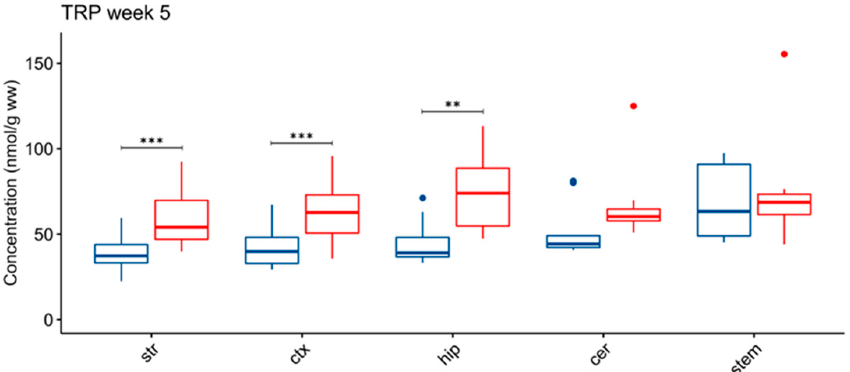
Figure 6. Elevated tryptophan concentrations in some brain regions in the cuprizone-treated group. In the 3rd week of CPZ treatment, the TRP levels were significantly increased in the cortex and the hippocampus. By the 5th week, the TRP concentration was also significantly increased in the striatum during the CPZ treatment. cer: cerebellum; CO: control group; CPZ: cuprizone group; ctx: cortex: hip: hippocampus; stem: brainstem: str: striatum; ww: wet weight; TRP tryptophan; *: p < 0.05;